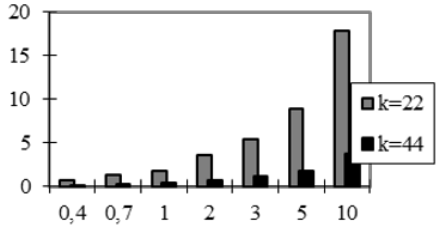
Fig. 4. Optimal dependence of particle radius on heat source relation, with η = π / 3, m = 10, ν = 5, k = 22;